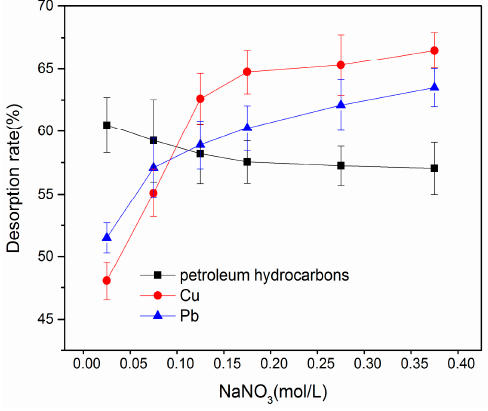
Figure 6. Effect of ionic strength on desorption.